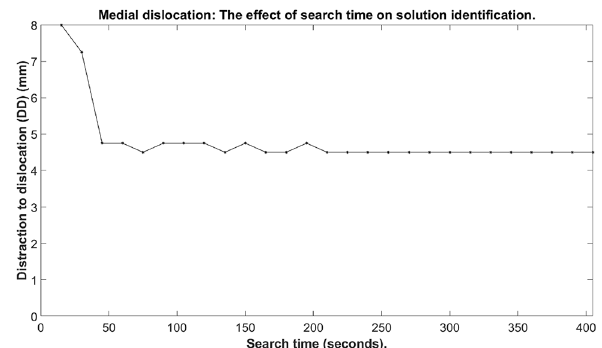
Figure 7. The effect of search time (s) on solution identification.